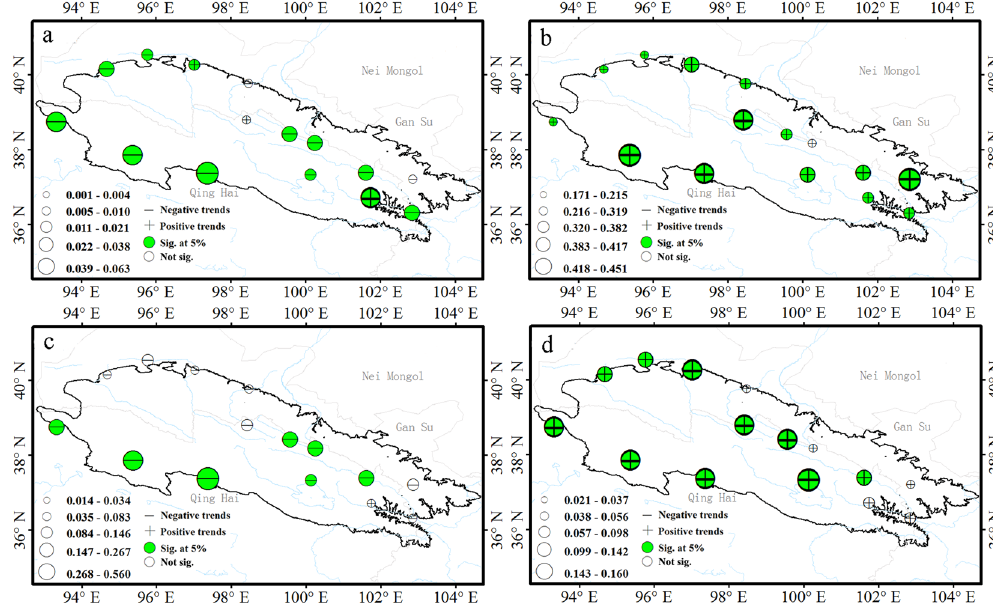
Figure 6. Spatial pattern of diurnal temperature range and duration indices. Diurnal temperature range ( a ), growing season length ( b ), cold spell duration ( c ), warm spell duration ( d ). For description of indices, see Supplementary Table S1. The size of the circles is the degree of changing. Positive trends are shown as pluses, negative trends as minuses. A green symbol indicates significance at the 5%; a white symbol represents non- significant trends. The maps are generated with Arc Map Ver 10.1 (http://www.esri.com/software/arcgis/arcgis-